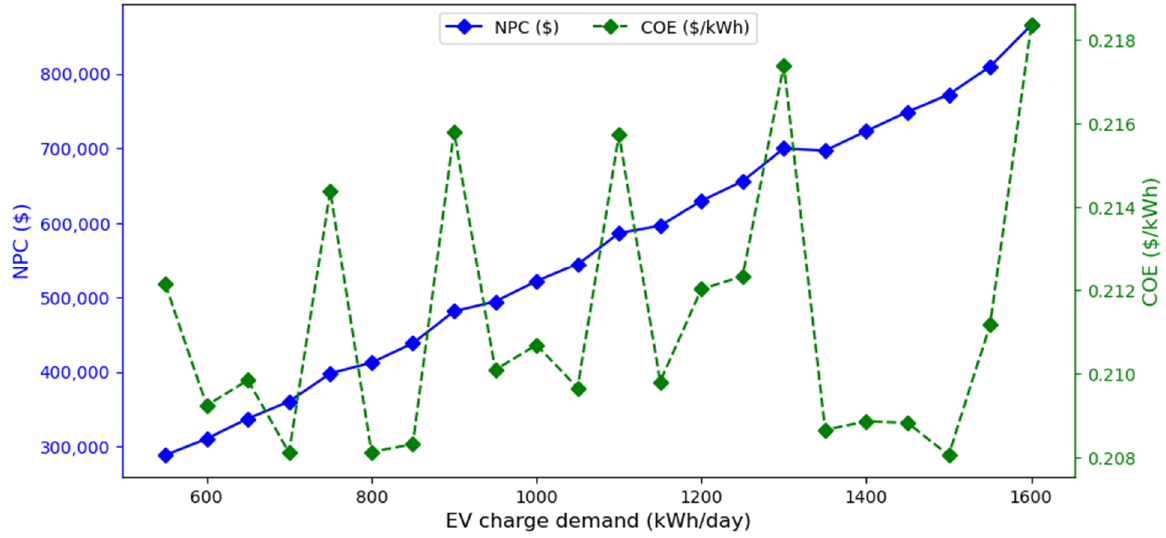
Figure 9. The effect of variation in the number of EVs or charge demand on the economic metrics NPC and COE of the PV/WT/battery charging system in Sokoto.